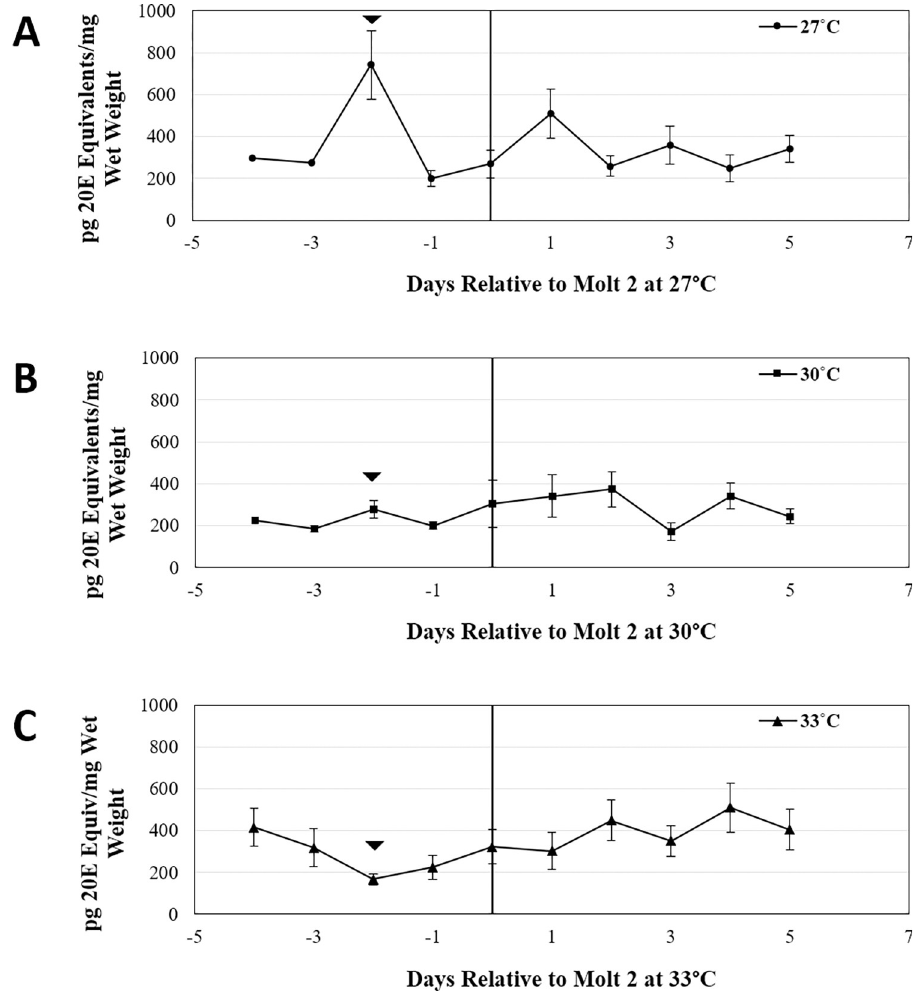
Fig 3. Normalized developmental ecdysteroid profiles. Average daily ecdysteroid titers from spiderlings reared at (A) 27˚C, (B) 30˚C and (C) 33˚C. Only families that had spiderlings reared at all three temperatures were used (N = 6 families). Spiderling ages are relative to the timing of the second molt for each family, at each temperature. The presumptive molt-inducing peak of ecdysone is indicated (arrowhead). Error bars represent standard